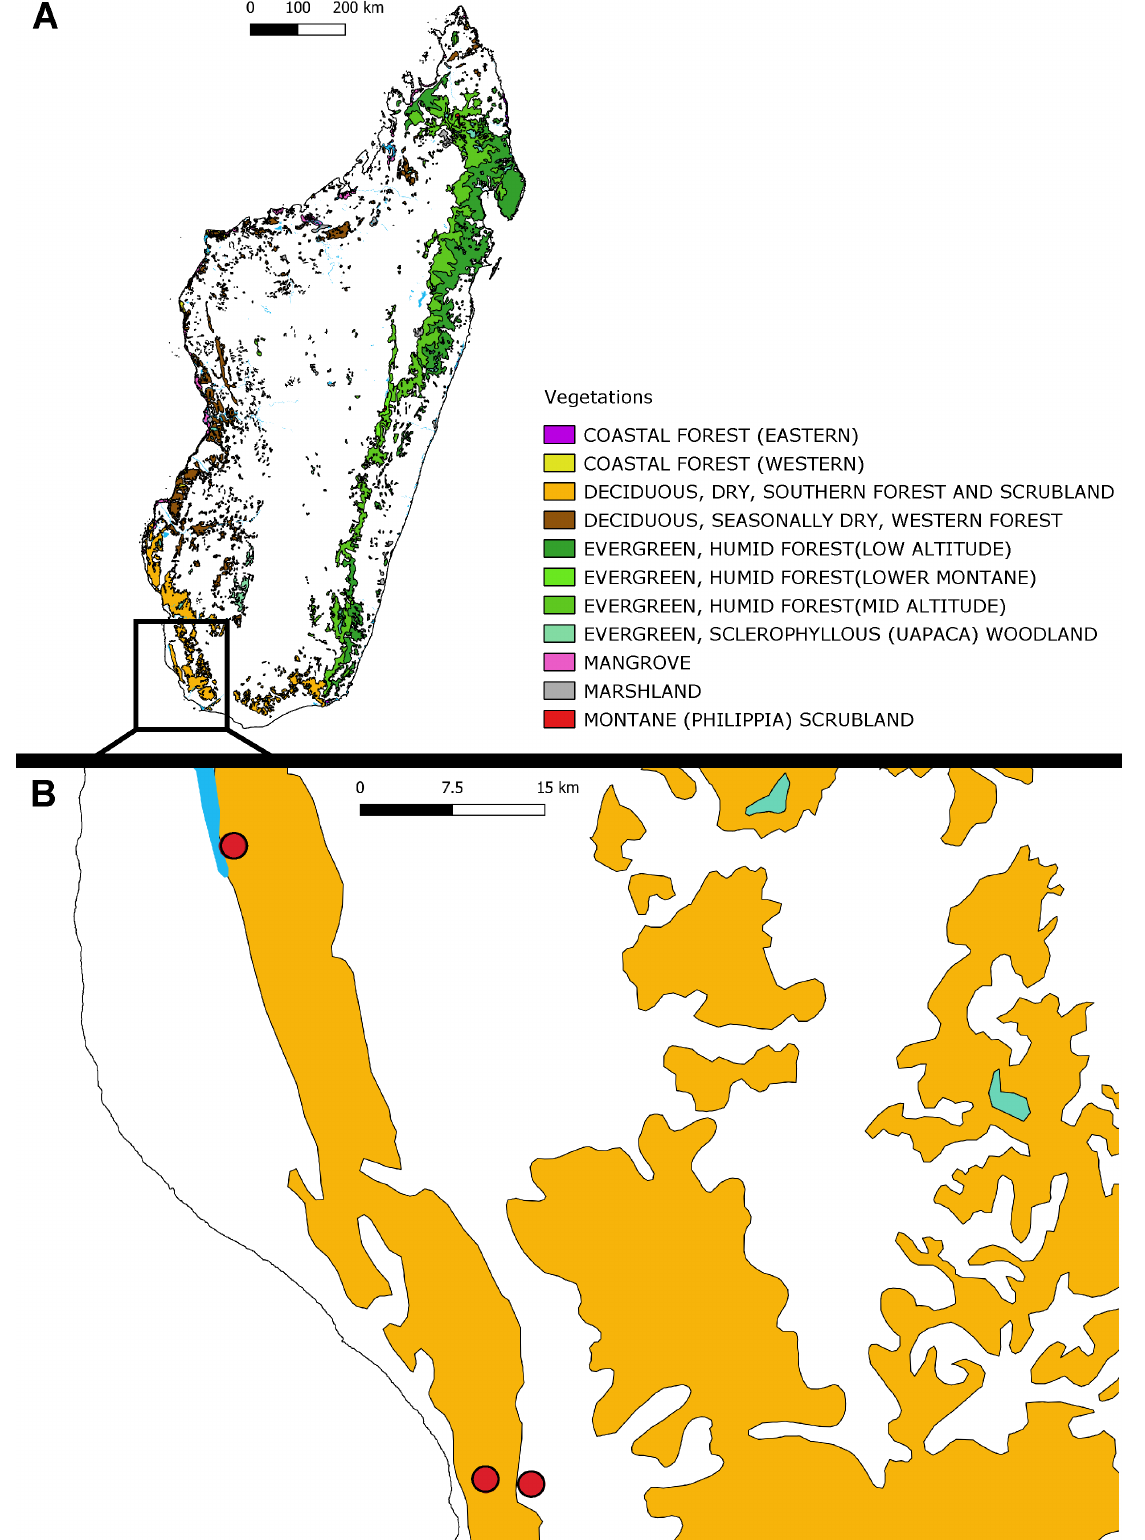
Fig. 6. Distribution of Dichromatobolus elephantulus gen. et sp. nov. Vegetation color marks modified from Moat & Smith